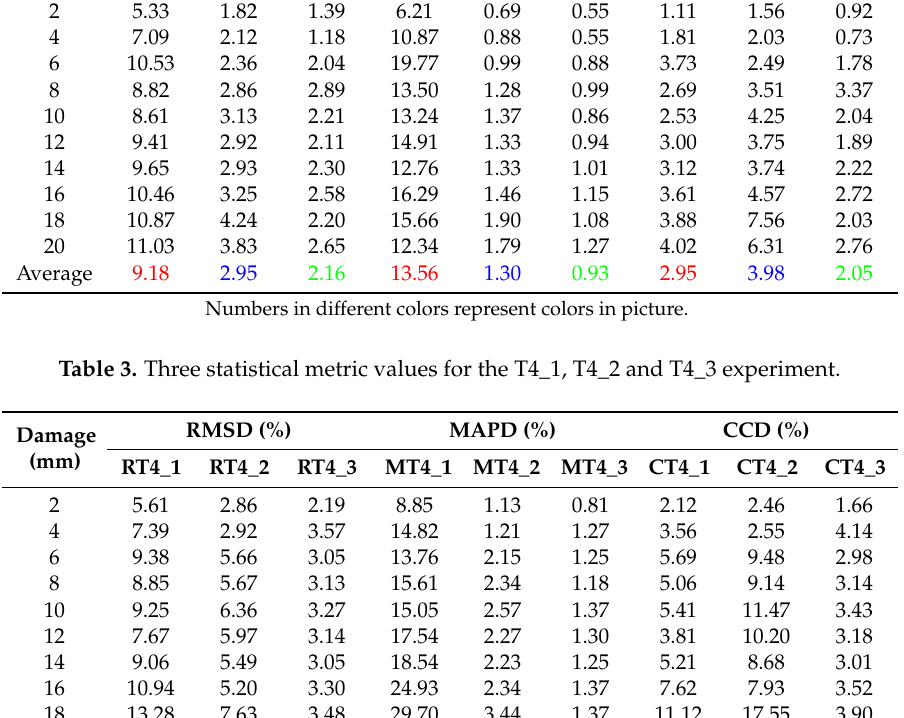
Table 2. Three statistical metric values for the T3_1, T3_2 and T3_3 experiment. Damage